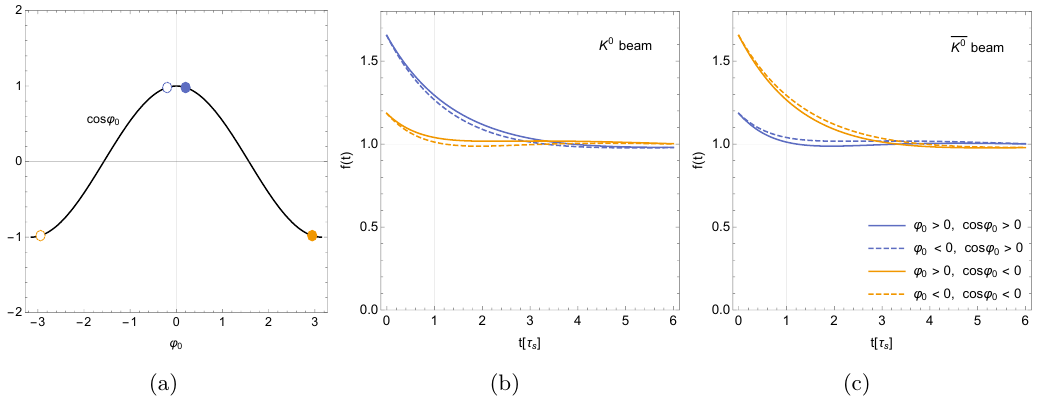
Figure 2 . (a) Illustration of the four-fold ambiguity arising from cos 2 ϕ 0 = 0 . 96 . (b) The time dependence of the K 0 ( t ) → µ + µ − rate, f ( t ) , as defined in eq. (1.1), for the four values of ϕ 0 . We have used a normalization in which C L of eq. (1.1) is set to unity. (c) The same for an initial pure K 0